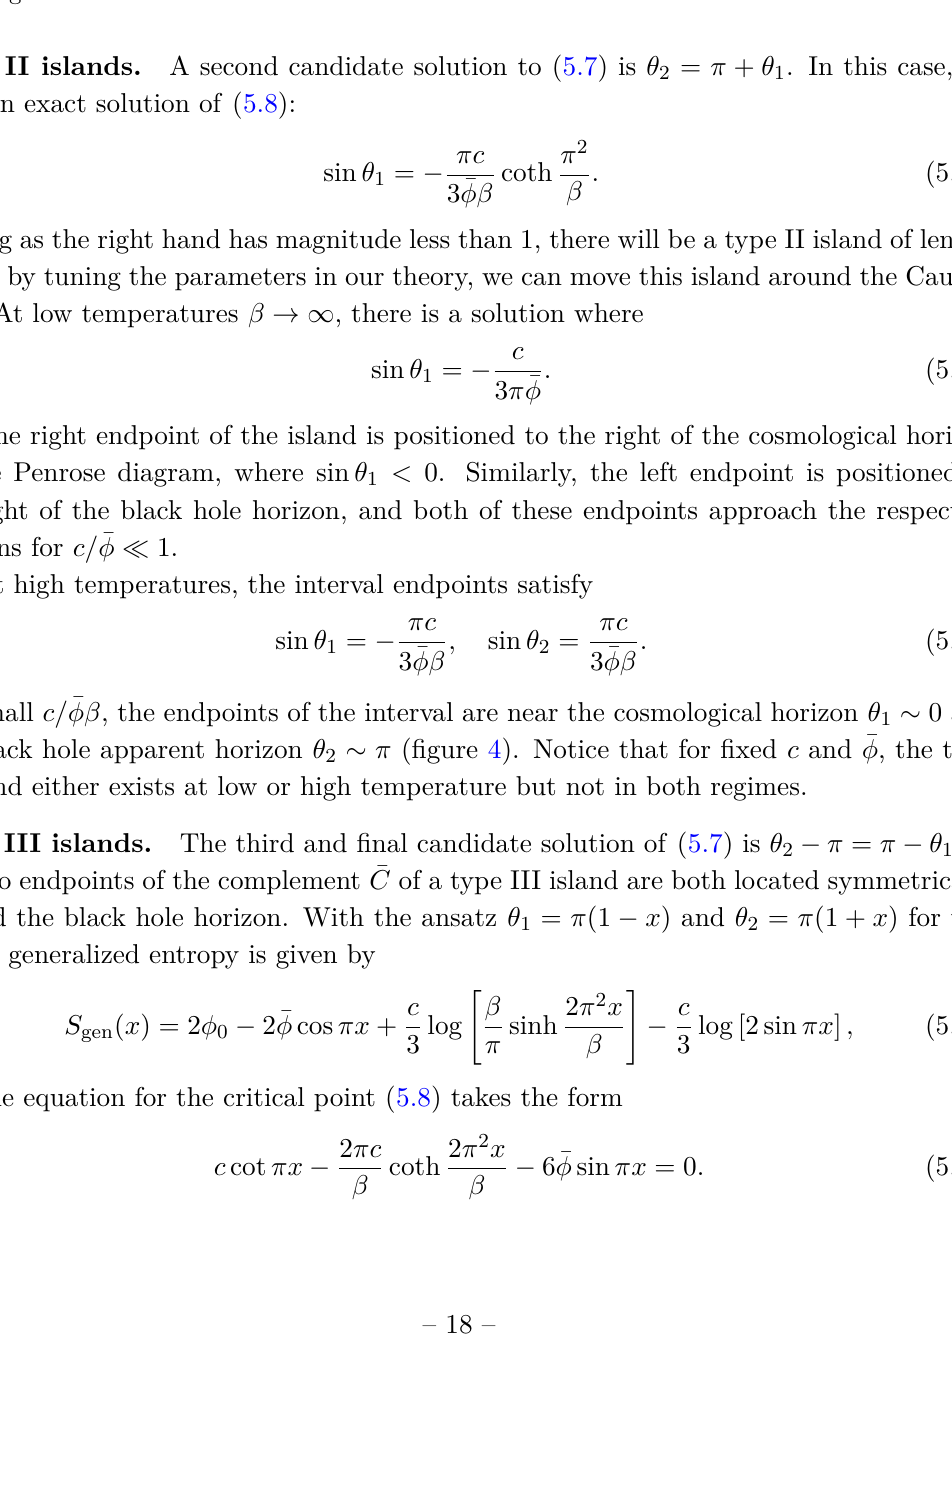
Figure 4 . Two types of islands C in the geometry without backreaction (3.4), with ζ = 0 . Instead of the islands themselves, we draw complementary regions of these islands ¯ C on the Cauchy slice τ = 0 (green lines). Left: the complement ¯ C of a type I island only contains the cosmological horizon. Right: the complement ¯ C of a type II island approximately connects the black hole and cosmological